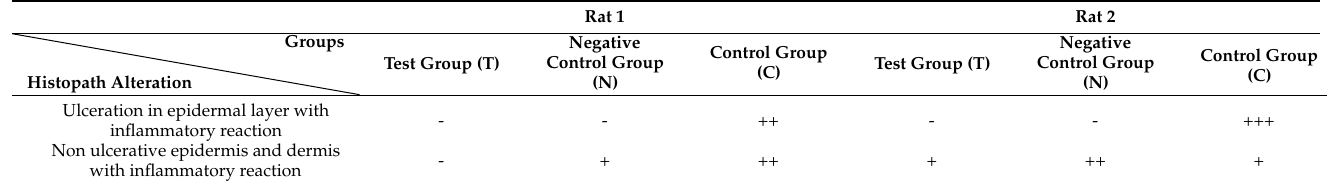
Table 3. Semi-quantitative assessment of pathological changes in different groups. Rat